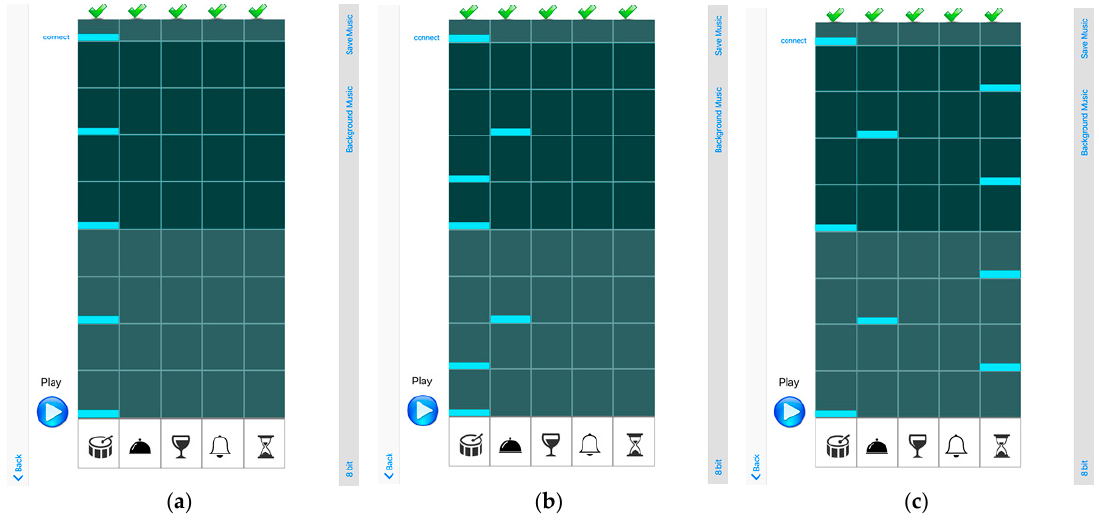
Figure 5. The edited scores of three different difficulties: ( a ) basic; ( b ) advanced; ( c ) difficult.